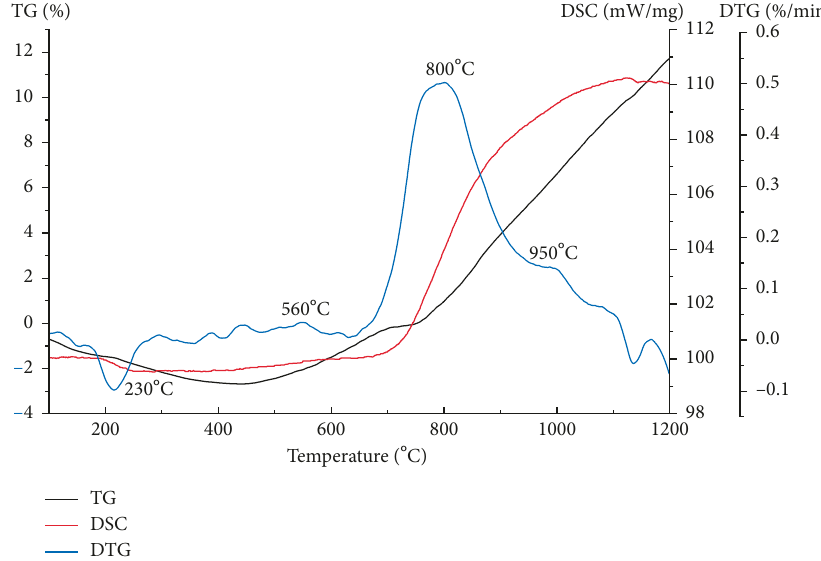
Figure 7: TG-DSC-DTG curve of Ti 2 SnC with ratio Ti : Sn: Al: C (cid:31) 2:1 :0.2:1 at 1400 °